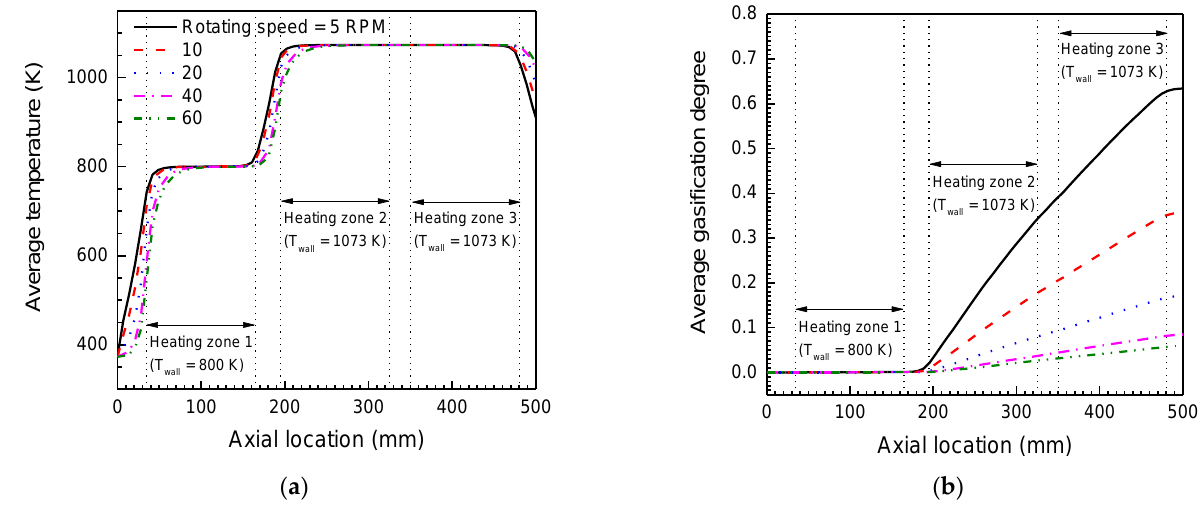
Figure 6. Predicted average cross-sectional temperature ( a ) and gasification degree ( b ) curves of graphite flow along the axial direction for various rotating velocities of the screw. Depending on the radioactive carbon distribution at the pretreated graphite particles, the screw reactor’s operating conditions are determined to decontaminate the radioactive graphite waste properly by controlling the gasification degree of the graphite particles. Figure 7 shows the numerically calculated gasification degrees of graphite particles flowing out of the screw reactor against their theoretical residence time, as determined using plug flow analysis. The average reaction progress at the reactor’s outflow rises linearly with increasing residence time as evaluated by the screw’s rotational velocity. The reaction rate at the same residence time increases as the screw reactor’s wall temperature rises. For all graphite particles flowing out of the screw reactor, when the temperature of the high temperature region of the reactor is less than 1023 K, the screw reactor can only gasify less than 12% of the input graphite particles. However, as the temperature rises to 1073 K, the screw reactor can gasify about 64% of the feed graphite at the residence time of 375 s, which corresponds approximately to the screw’s theoretical rotational velocity 5 rpm. Moreover, at a temperature of 1073 K, the rotational velocity of the screw at which more than 12% of the feed graphite is gasified, increases to about 66 rpm, corresponding to the theoretical residence time of 67 s.